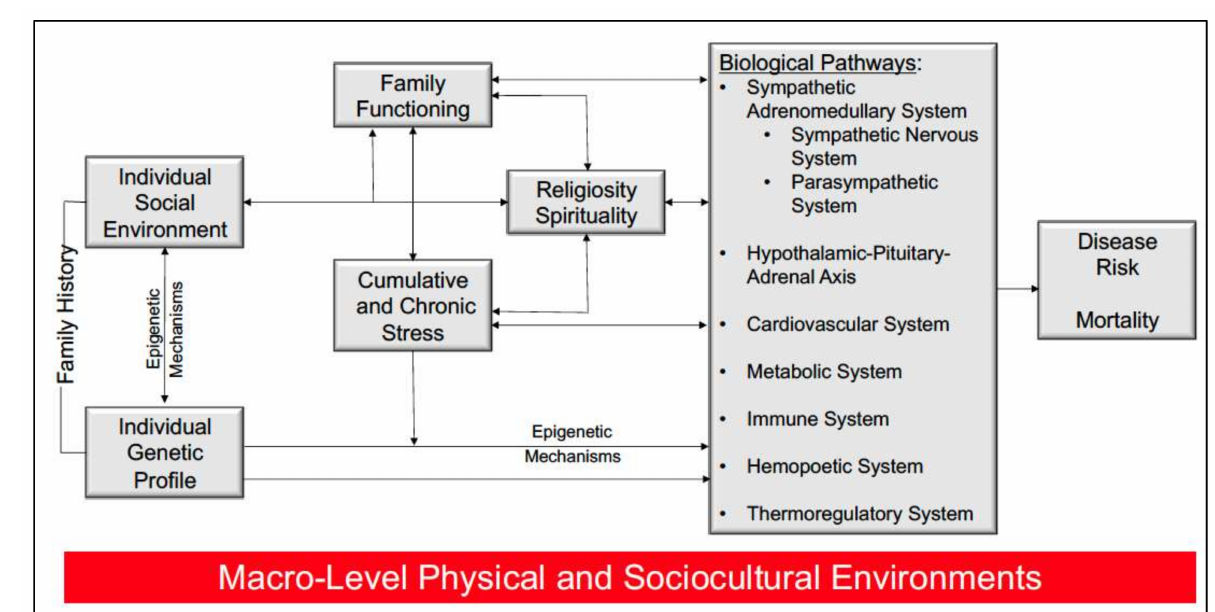
Figure 1. Biopsychosocial model of disease risk and mortality that emerged from Bruce and Thorpe [24].